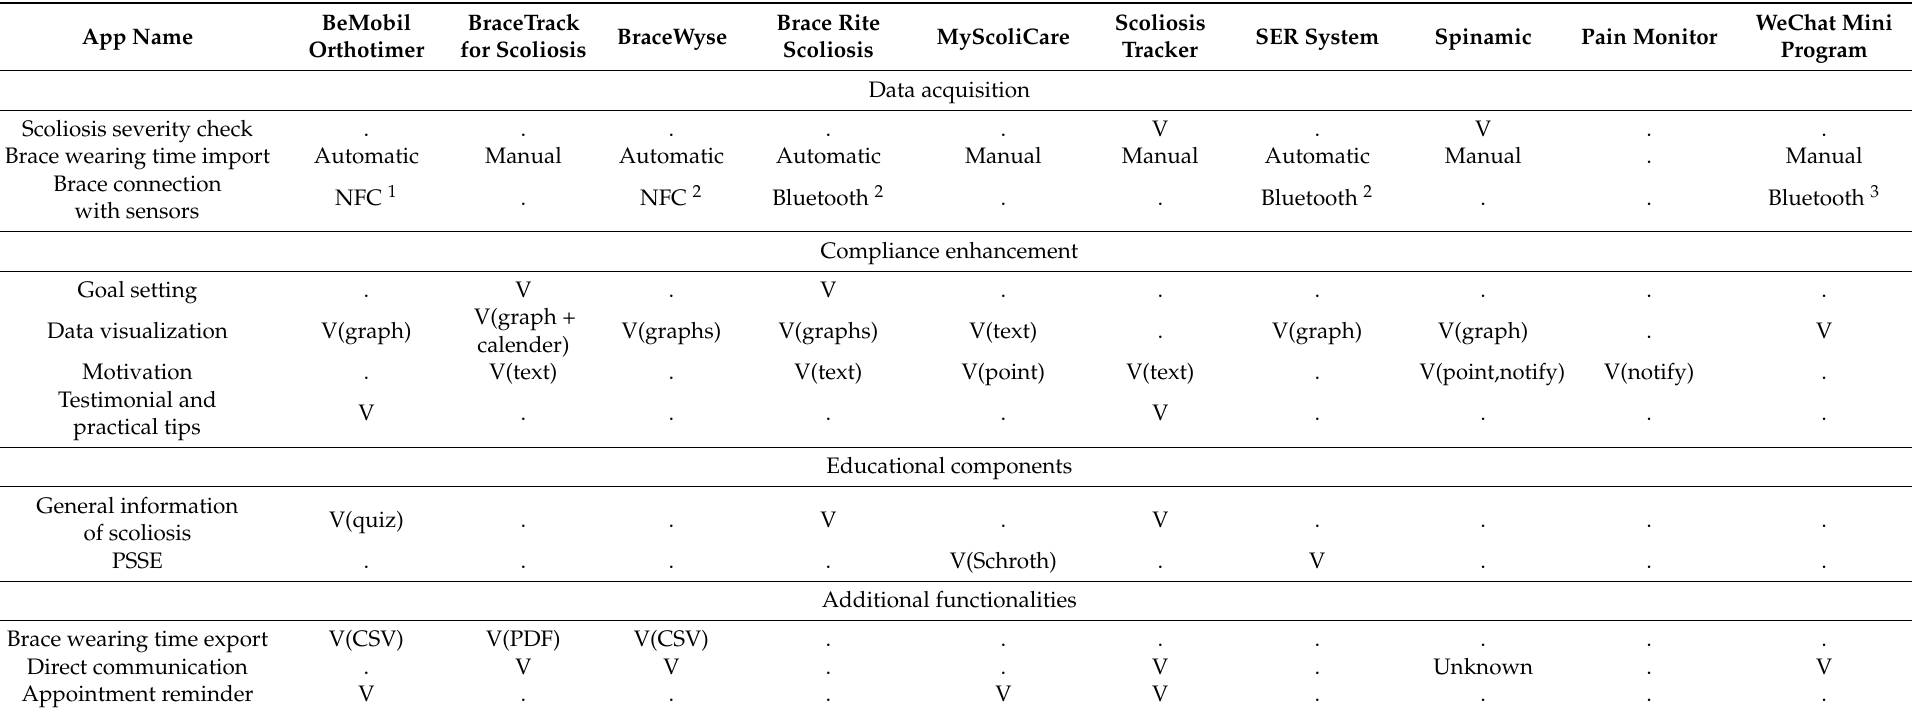
Table 2. Summary of functionalities provided by mHealth